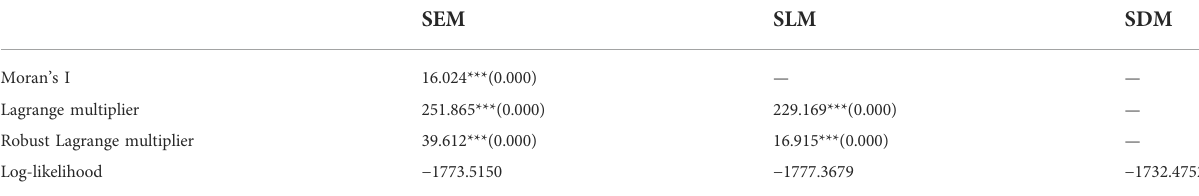
TABLE 4 Selection of spatial econometric models.